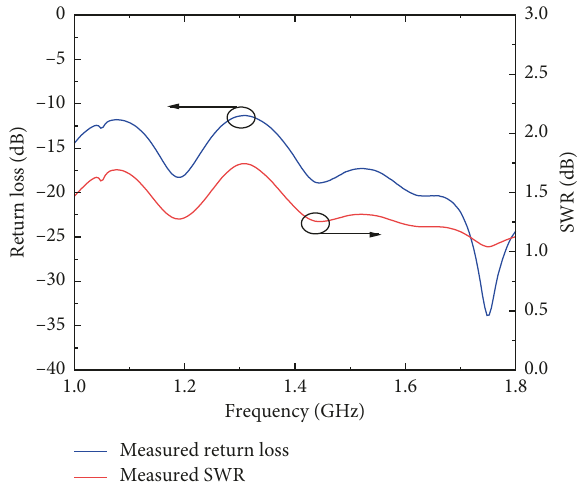
Figure 8: The measured return loss and SWR.